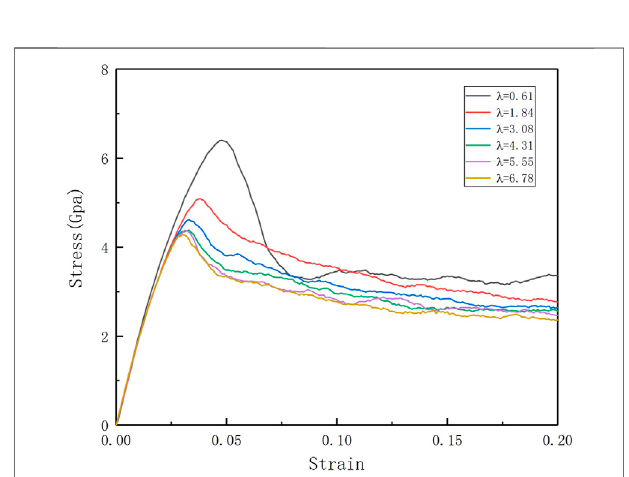
FIGURE 2 | Stress-strain curves of nt-HEAs model with different distances between twin boundaries under tension at 300 K.